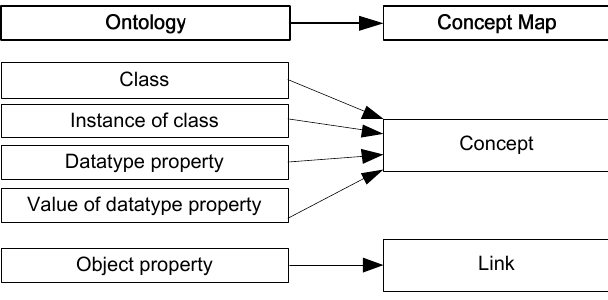
Fig. 5. Correspondence between elements of ontology and elements of concept map